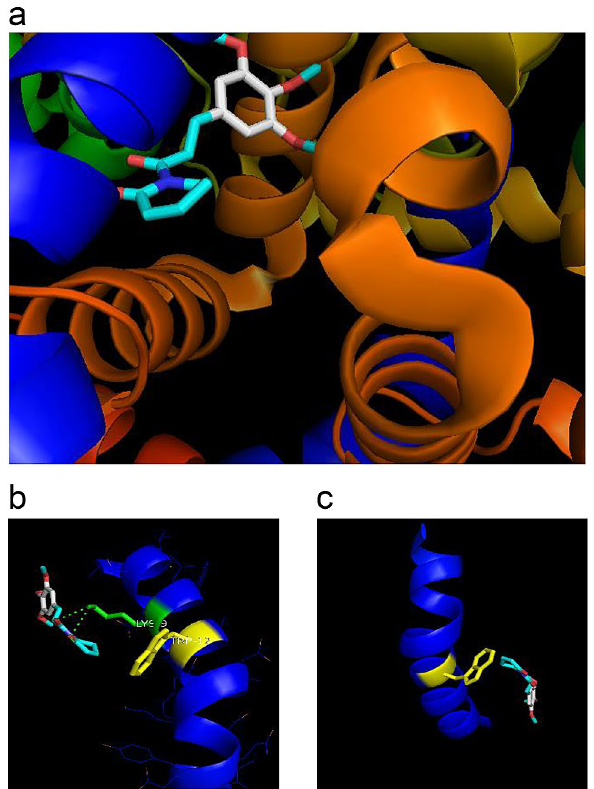
Figure 1. The docked position of PL onto the Ac 2-26 peptide. ( a ) Secondary structure of annexin A1 is represented in orange, Ac 2-26 peptide in dark blue and PL as sticks. ( b , c ) As shown, the Ac 2-26 peptide binds to PL via two hydrogen bonding interactions (dotted lines) at lysine 9 (in green) but not at tryptophan 12 (in yellow). Data were taken, with permission, from experiments performed by the author Henrique T 95 , and figure printed in 96 . Figure was generated by Pymol system version 2.0 (https ://pymol .org/).